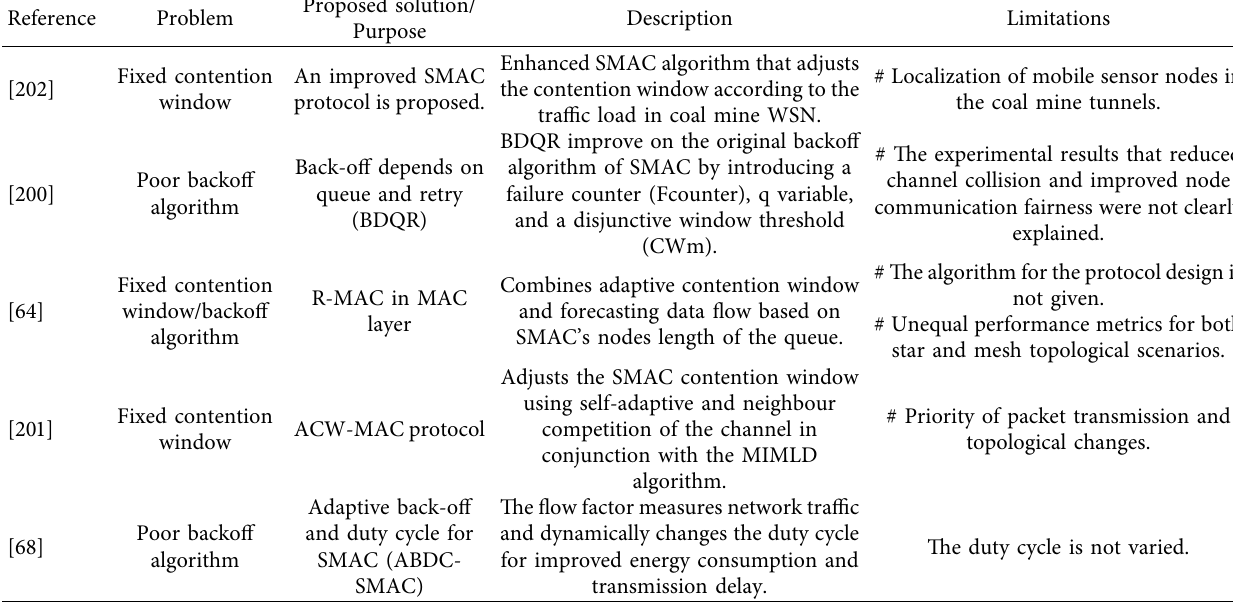
Table 10: Enhanced protocols/algorithms for fixed contention window/poor backoff